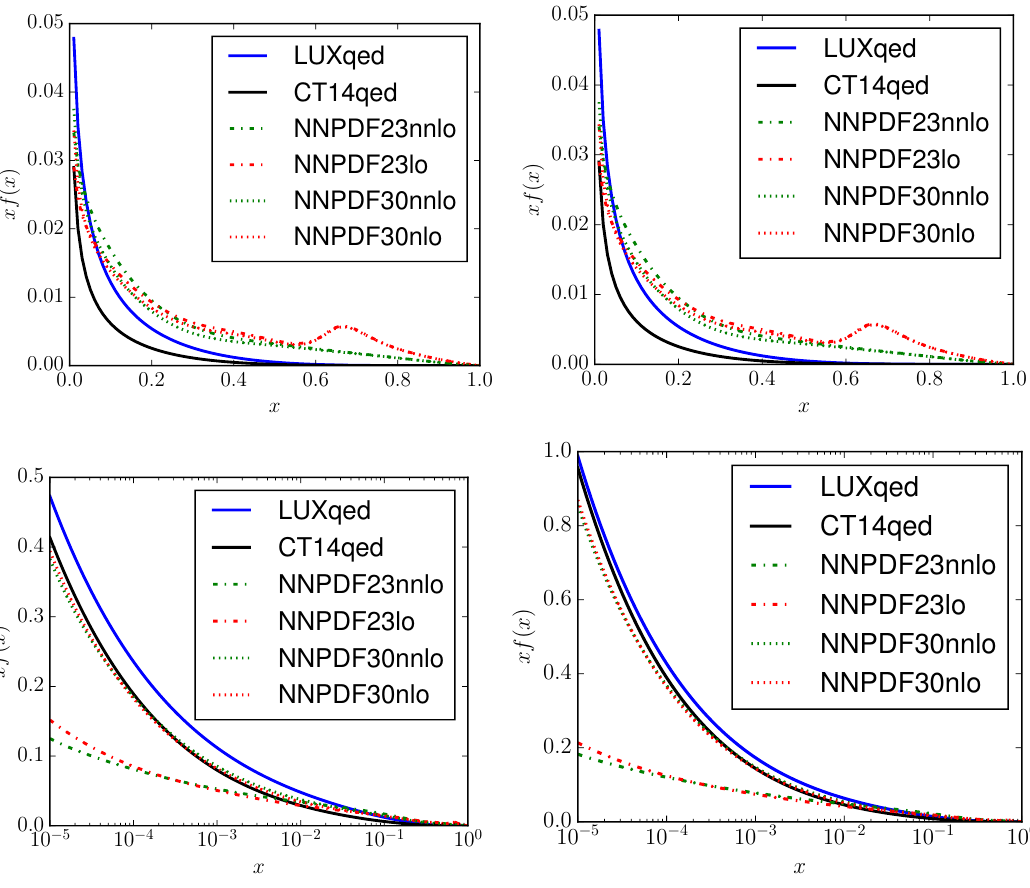
Figure 7 . Top panel: product of the photon distribution function by x . Dashed lines, NNPDF2.3; dotted lines, NNPDF3.0 (colors online on both cases for LO, NLO and NNLO). Solid black line: CT14qed set. Solid gray line (blue online): e(cid:11)ective \pdf" for the resonance (not necessarily DIS) region, LUXqed. The left plot takes a characteristic energy scale (cid:22) = 100 GeV, the right plot (cid:22) = 1 TeV. Note that (cid:22) p s (cid:13)(cid:13) can be much larger than the actual energy scale of the (cid:24) photoproduction process, Q . See explanation on page 21. Bottom panel: logarithmic scale to appreciate the low- x